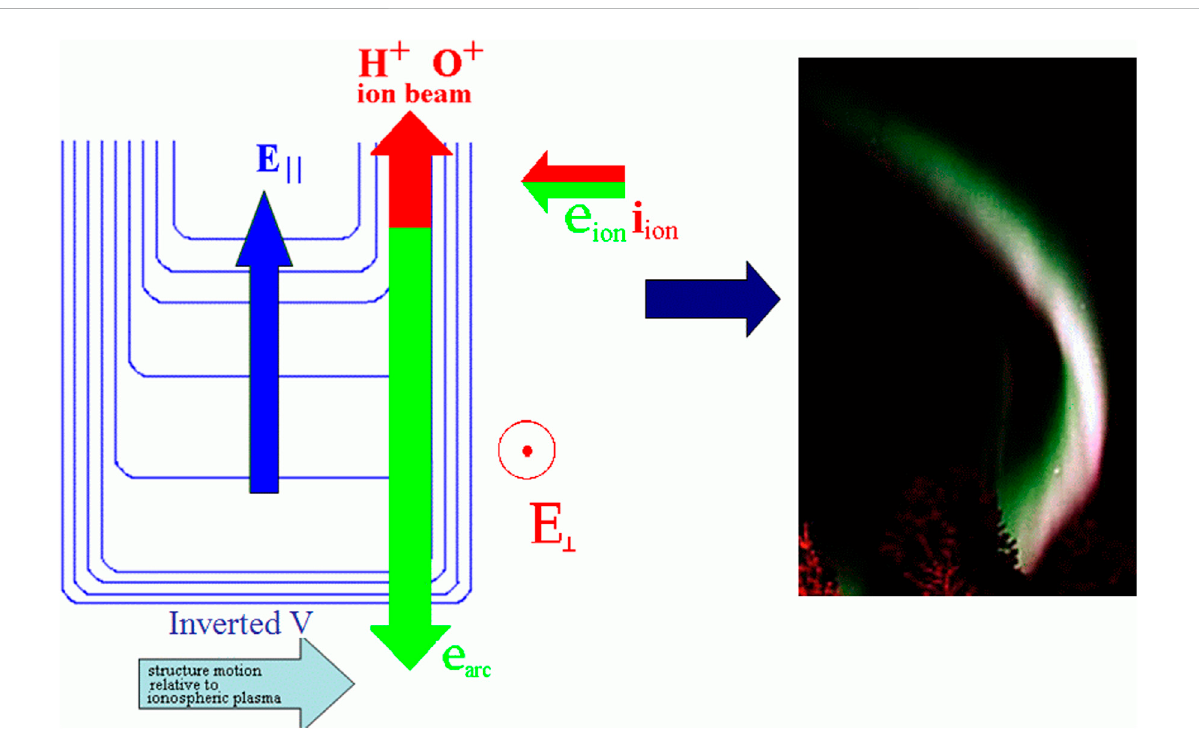
FIGURE 1 Formation of thin bright auroral arc at the boundary of the inverted V/U structure with particle fl ux J~10 11 cm − 2 s − 1 due to penetration of cold ionospheric plasma inside the plasma cavity [ “ grader model ” in accordance with (Antonova et al.,